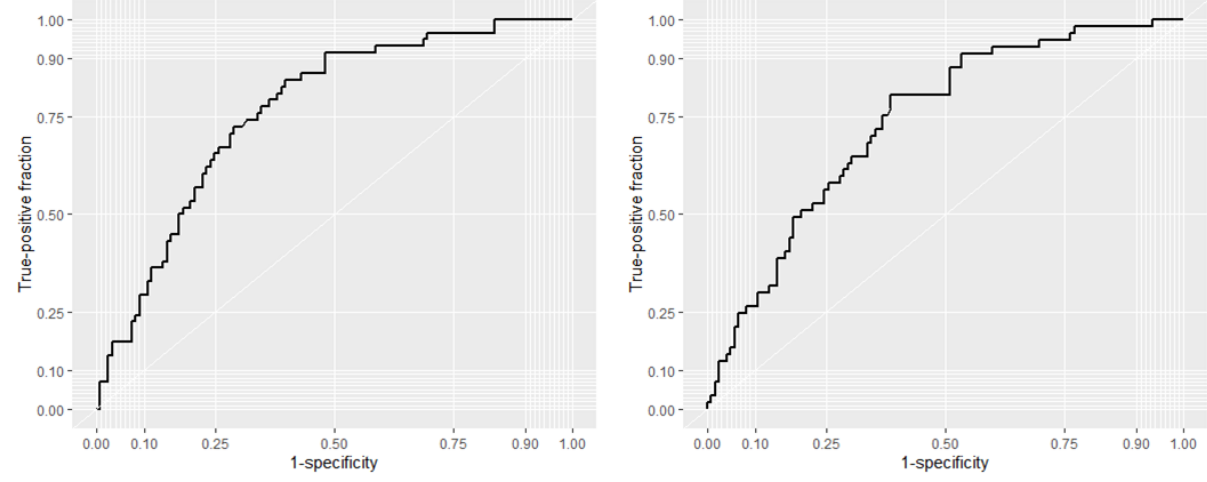
Figure 2. Receiver operating curves showing performance of lasso-selected predictors to predict general health information (left) and sexual and